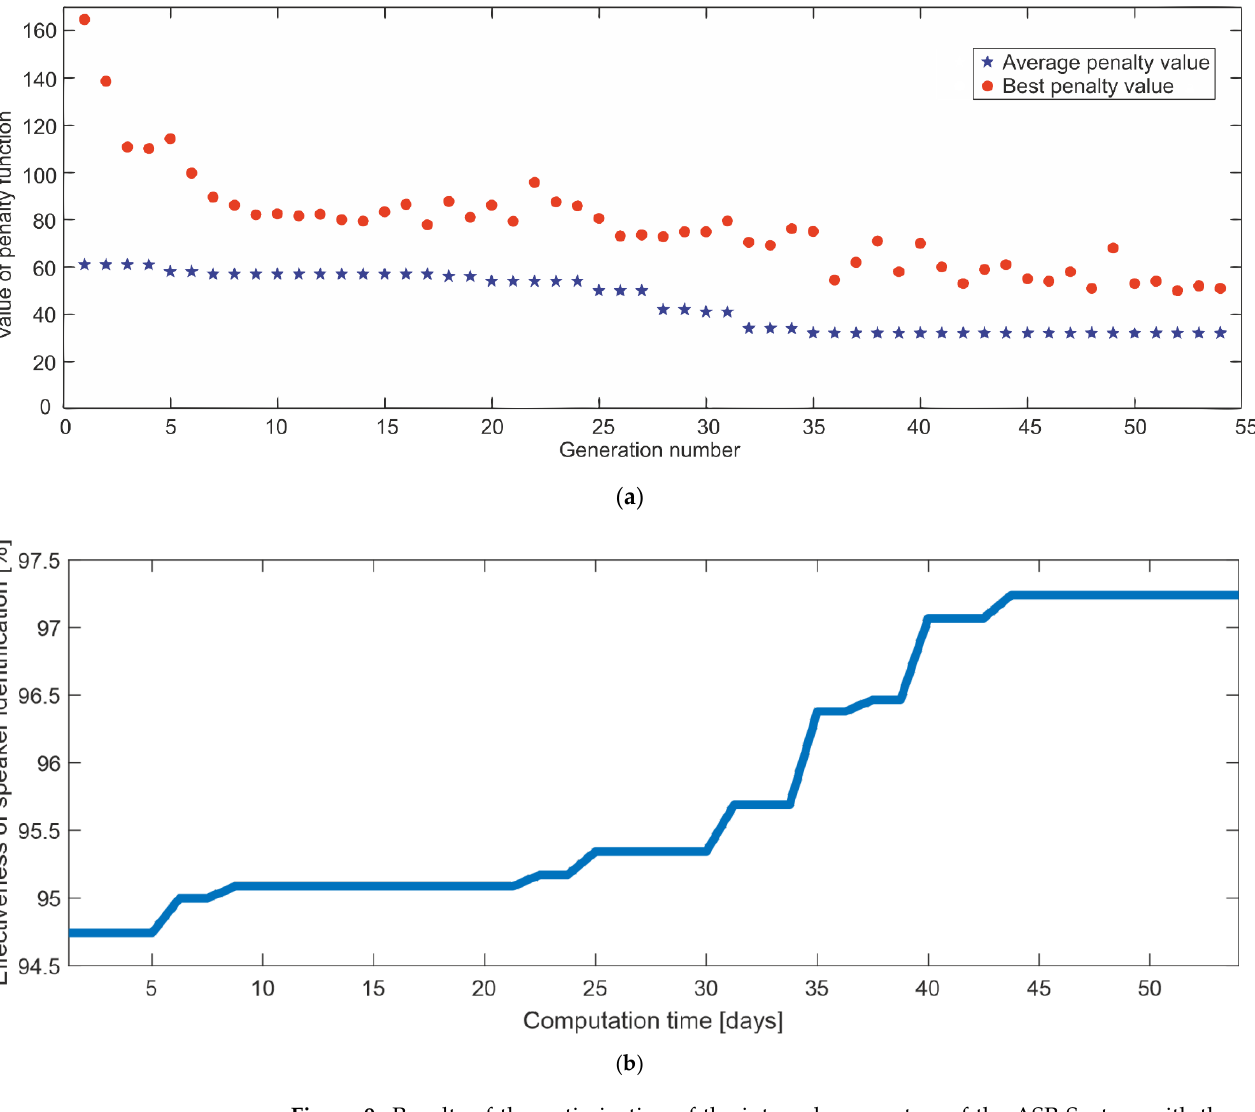
Figure 9. Results of the optimization of the internal parameters of the ASR System with the use of a genetic algorithm, ( a ) — value of the penalty function in relation to the number of generations; ( b ) — Effectiveness of speaker identification in relation to the calculation time.